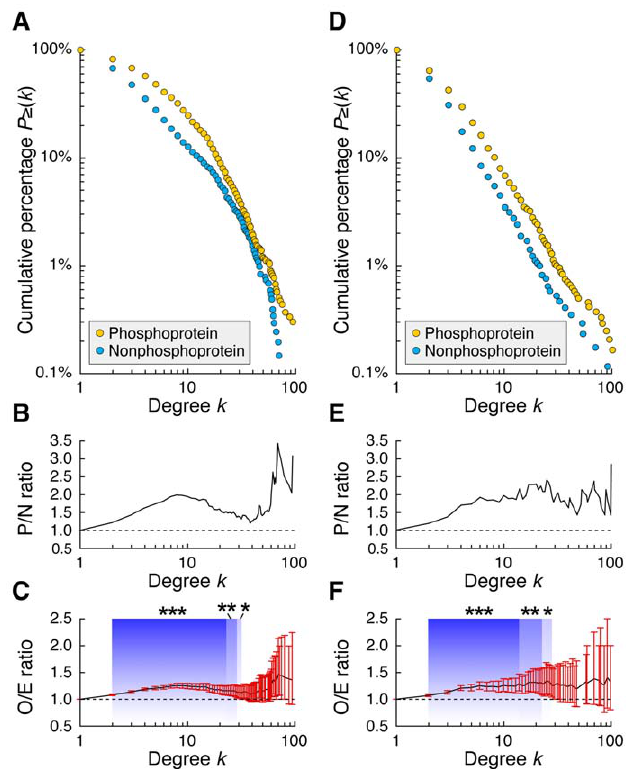
PLoS Computational Biology |